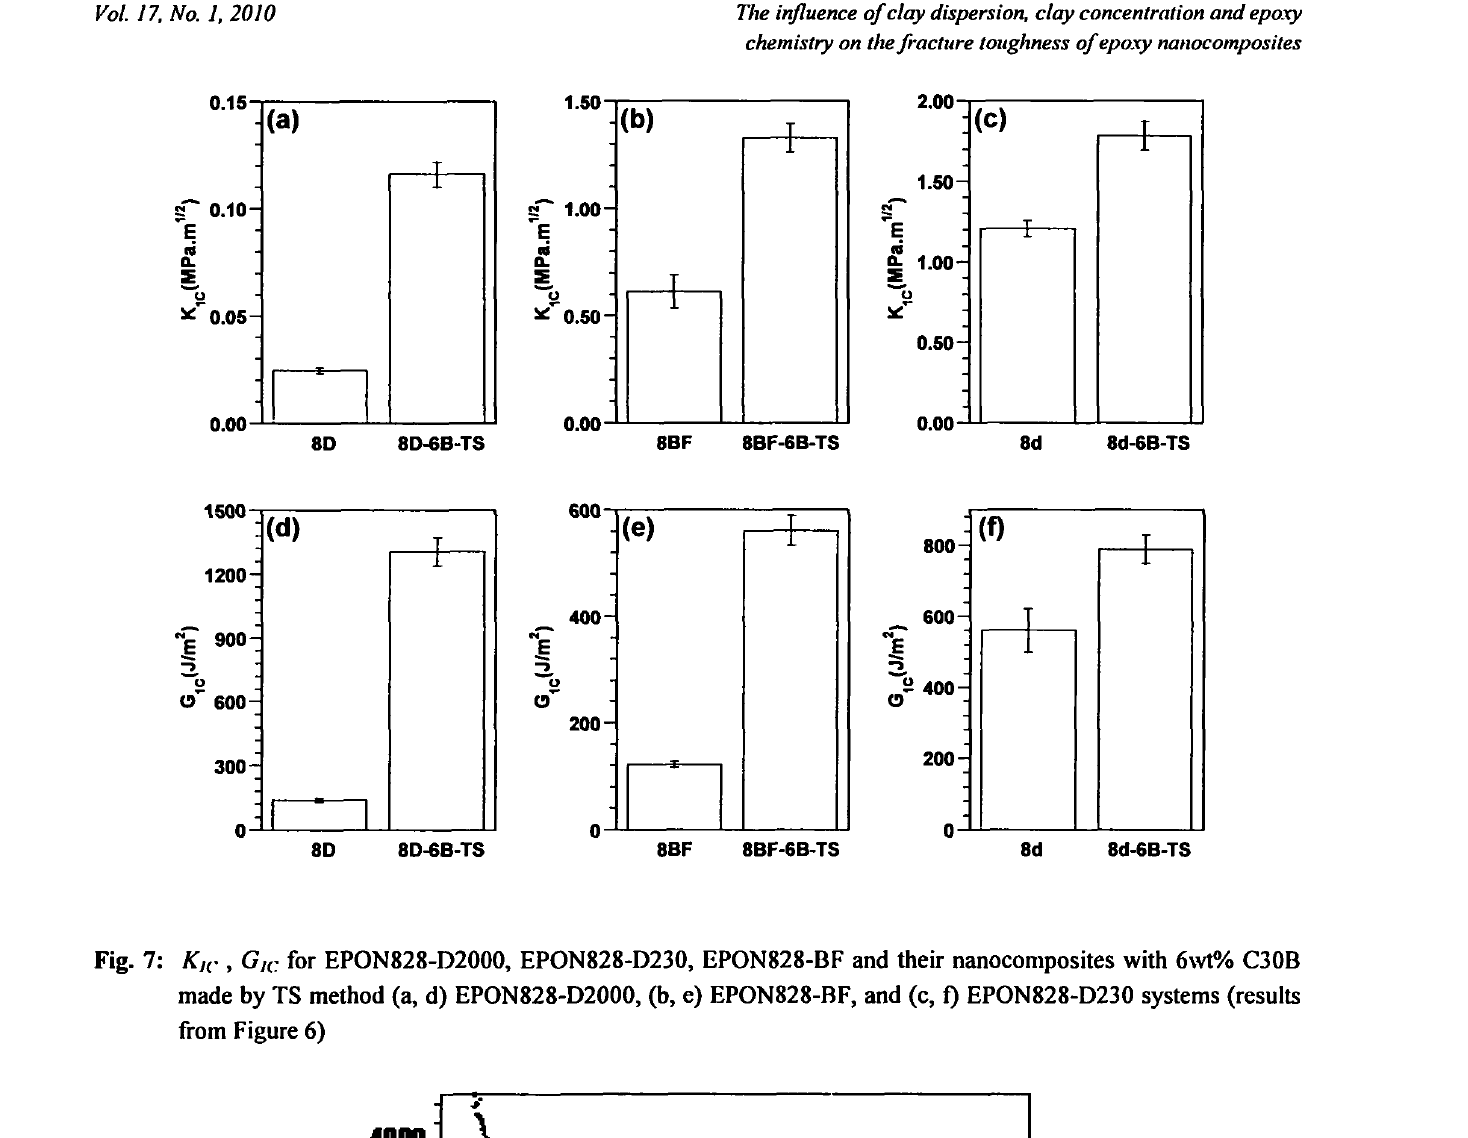
Fig. 1\ K, , G, for EPON828-D2000, EPON828-D230, EPON828-BF and their nanocomposites with 6wt% C30B c c made by TS method (a, d) EPON828-D2000, (b, e) EPON828-BF, and (c, f) EPON828-D230 systems (results